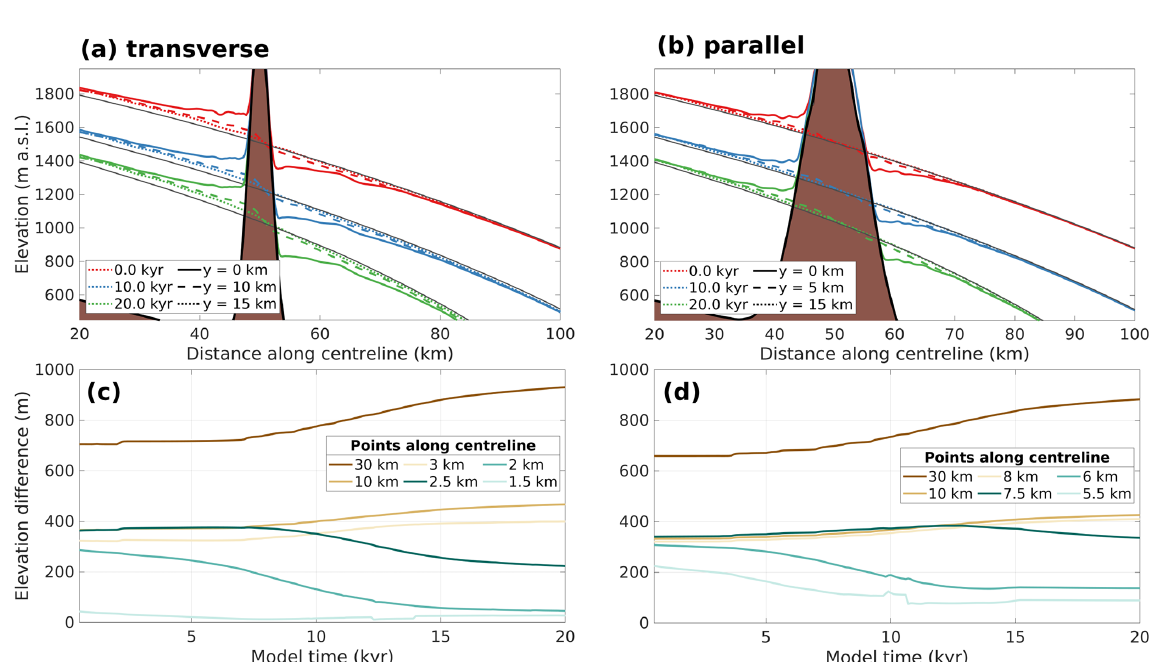
Figure 5. Surface elevations after 0, 10, and 20kyr for the thw experiment with a nunatak elongated (a) transversely and (b) parallel to ice flow at 0, 10, and 15km from the centreline; dark grey lines show the respective ice surface elevation for experiments without a nunatak; (c, d) evolution of the ice surface elevation difference between six pairs of equidistant points up- and downstream of the nunatak, along the centreline for the experiments showcased in (a, b) , respectively. In short, this figure shows to what extent a single nunatak is able to influence ice surface elevation in space (along and perpendicularly to flow) and through time, how ice surface elevation is linked to a nunatak’s subglacial topography, and how the ice surface elevation mismatch evolves differently depending on the distance from the